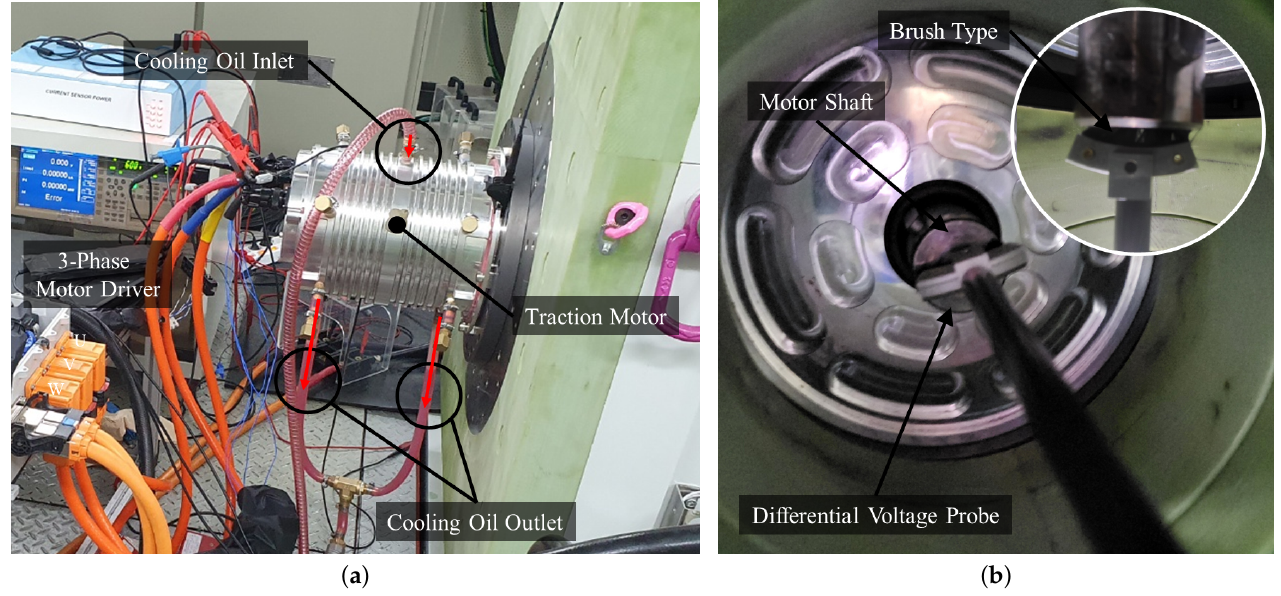
Figure 17. Photographs of the experimental setup. ( a ) Traction motor; ( b ) Shaft voltage measurement.